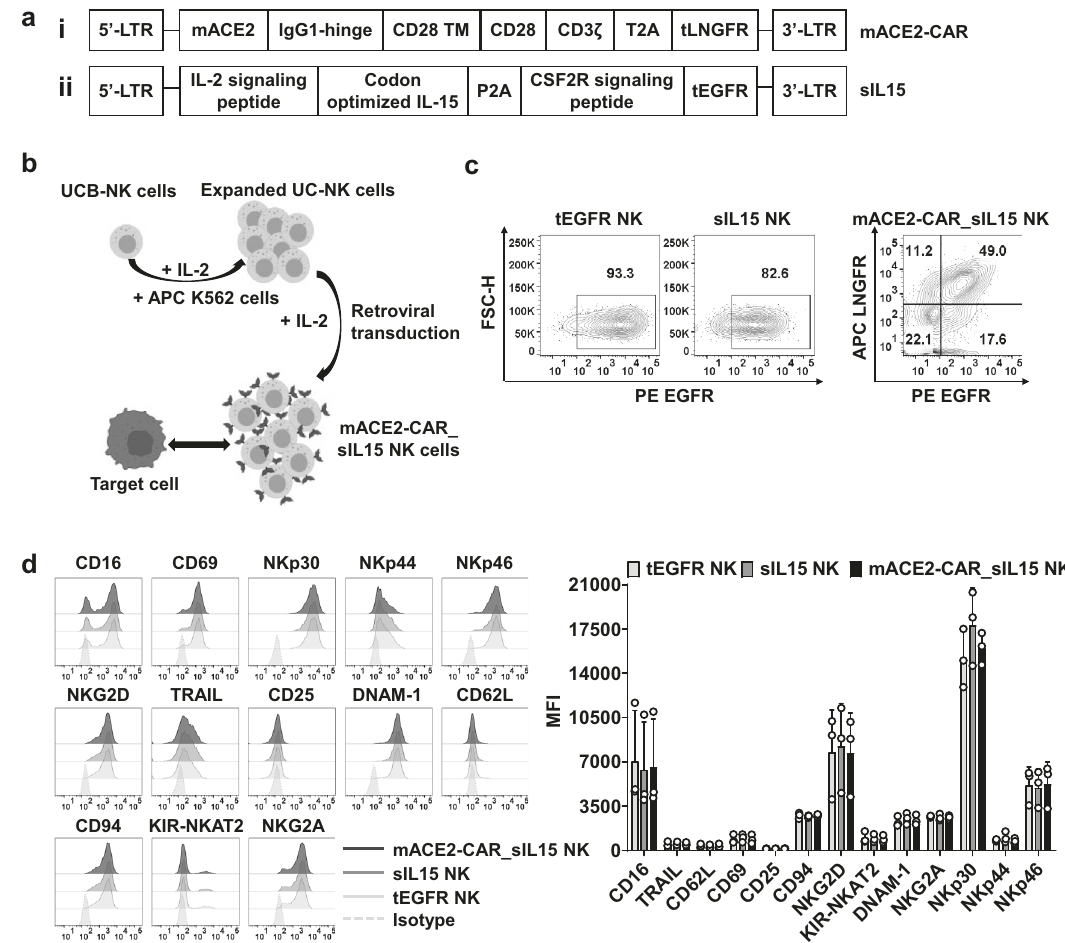
Fig. 1 Generation of mACE2-CAR_sIL15 NK cells. a Design of the mACE2-CAR and sIL15 retroviral vectors. The mACE2-CAR vector contains a mutant human ACE2, a human IgG1-hinge region, and the CD28 transmembrane region, followed by the intracellular domains of CD28 and CD3 ζ linked to a T2A and a truncated (t) LNGFR (i). The sIL15 vector contains an IL-2 signaling peptide, a codon-optimized IL-15, and the GM-CSF receptor (CSF2R) signaling peptide, followed by a truncated (t) EGFR (ii). b Generation of mACE2-CAR_sIL15 NK cells. The pictures were created with BioRender.com. c The transduction ef fi ciency of control tEGFR or sIL15 NK cells and mACE2-CAR_sIL15 NK cells was determined by fl ow cytometry. Control tEGFR or sIL15 NK cells expressed the tEGFR marker, while mACE2-CAR_sIL15 NK cells expressed the tLNGFR maker (representing mACE2-CAR expression) as well as the tEGFR marker (representing sIL15 expression). d The phenotypic analysis of mACE2-CAR_sIL15 NK cells and control tEGFR or sIL15 NK cells were determined by fl ow cytometry. Representative fl ow cytometry histograms and summary data from three different donors are shown. P values were determined by one-way ANOVA with multiple comparisons and adjusted by the Holm-Sidak method. Data are presented as mean ± SD. For mACE2- CAR_sIL15 NK cells, sIL15 expression is denoted as LNGFR – EGFR + , mACE2-CAR expression is denoted as LNGFR + EGFR – , and sIL15 & mACE2-CAR_co- expression is denoted as LNGFR + EGFR + . Source data are provided as a Source Data fi